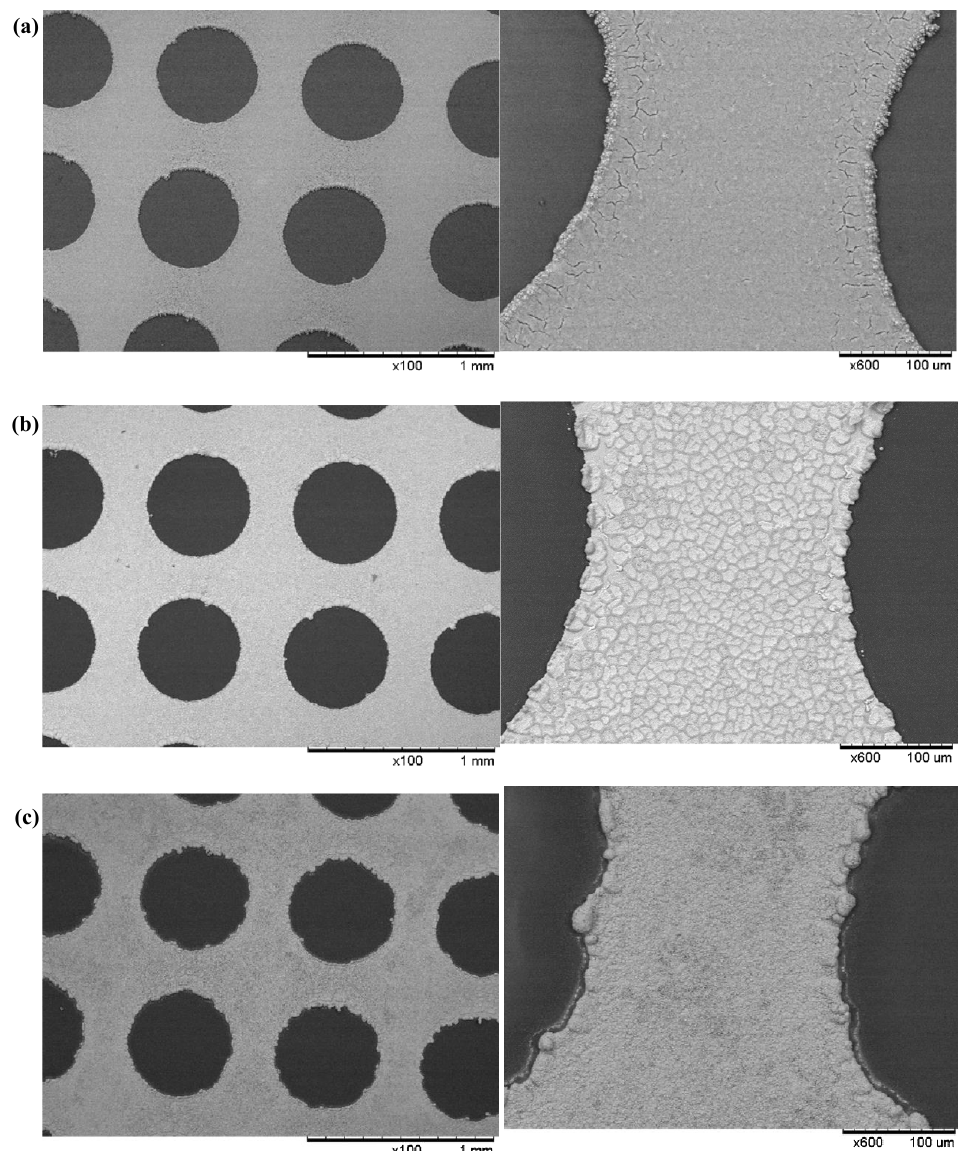
Fig. 3. (a) SEM image of localized co-electrodeposited mixed hydroxides thin layer (Cu(OH) 2 , In(OH) 3 , GaOOH) (cid:1) (b) SEM observation of the surface of Cu-In-Ga after H 2 annealing at 520 ° C (cid:1) (c) SEM observation of the surface of Cu(In,Ga)Se 2 after selenisation annealing at 580 ° C (cid:1) [for each, left: view of several patterns ; right: zoom on a channel between two holes].